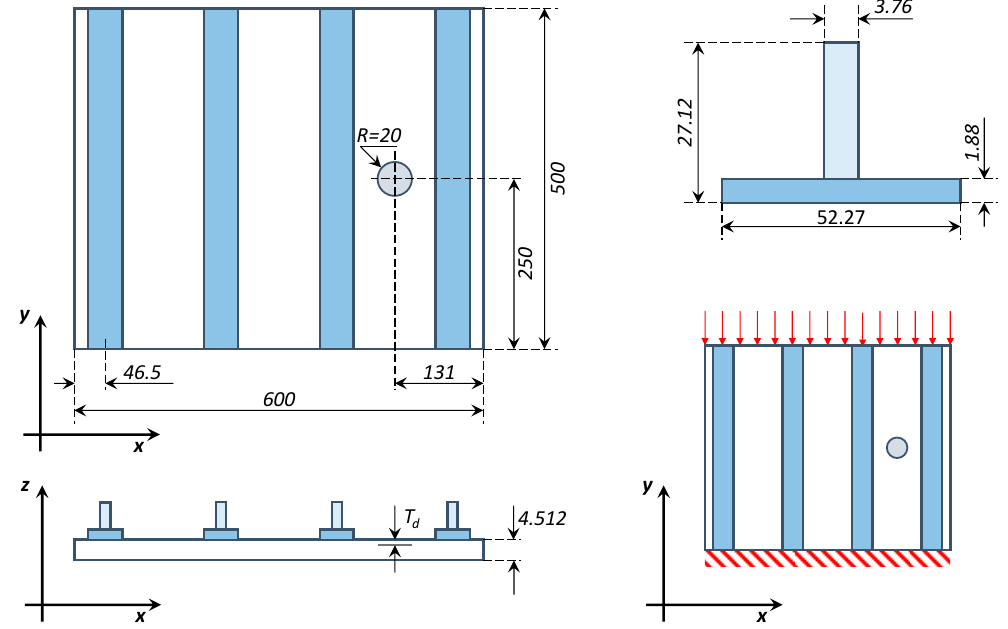
Figure 5. Test case 1 geometrical description (dimensions in mm) and boundary conditions. Table 1. AS4/3501-6 material properties.